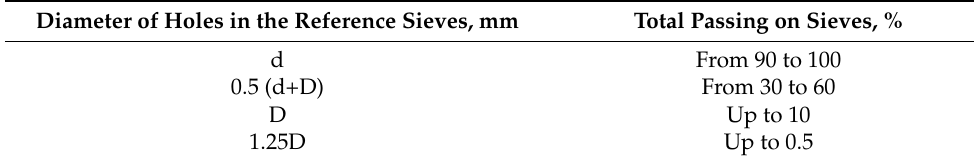
Table 5. Recommended coarse aggregate sieving parameters [22]